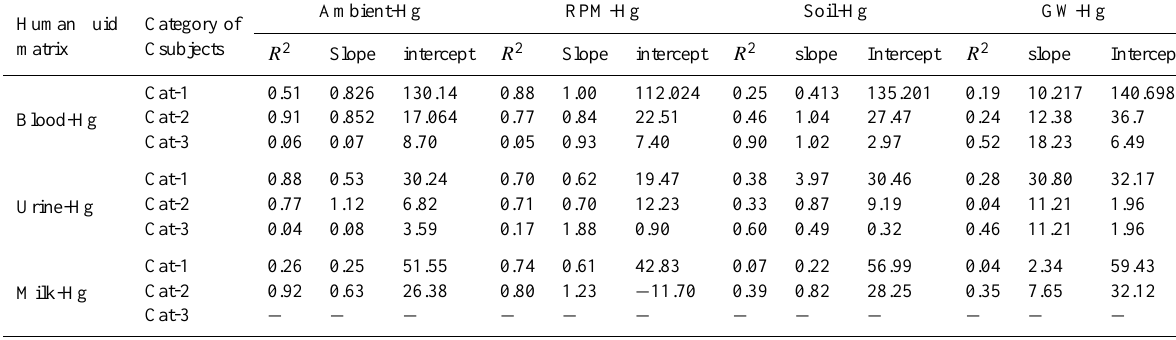
Table 6. Regression data of Hg levels in human biological fluid with its exposure matrices around steel plant, Bhilai. Ambient-Hg RPM-Hg Soil-Hg GW-Hg Human fluid Category of matrix Csubjects R 2 Slope intercept R 2 Slope intercept R 2 slope Intercept R 2 slope Intercept Cat-1 0.51 0.826 130.14 0.88 Blood-Hg Cat-1 0.88 Urine-Hg Cat-1 0.26 0.25 51.55 0.74 0.61 0.92 0.63 26.38 0.80 1.23 − 11.70 32.12 Milk-Hg Cat-3 − − − − − − − − − − − − GW-Hg: Mercury level in ground water used for drinking